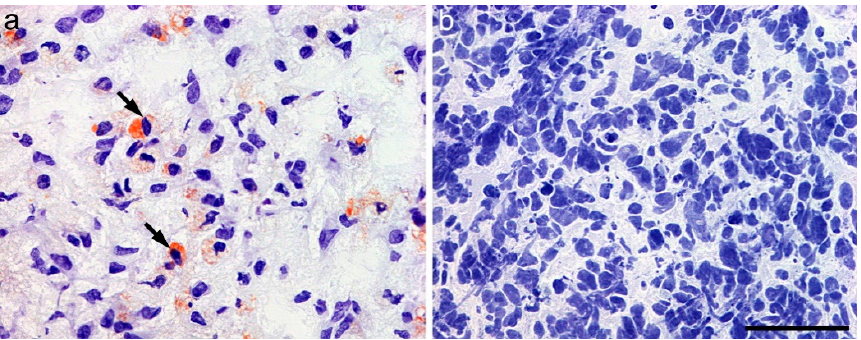
Figure 6. Intracytoplasmic lipid droplets in ( a ) glioblastoma and ( b ) astrocytoma, IDH-mutant, CNS WHO grade 4 (scale bar 100 µm).